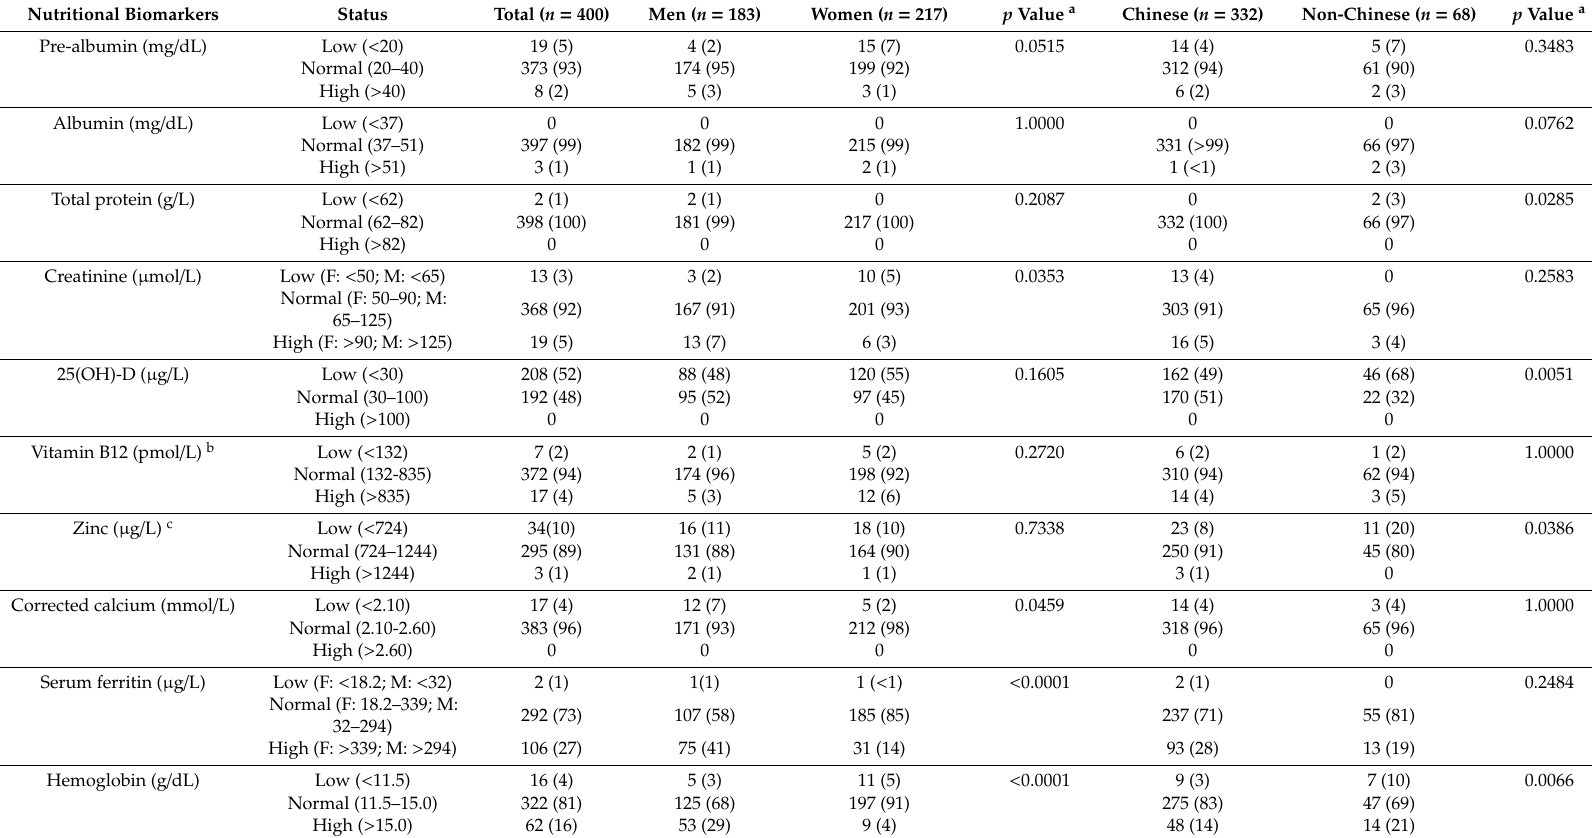
Table 2. Nutritional biomarkers status by gender and